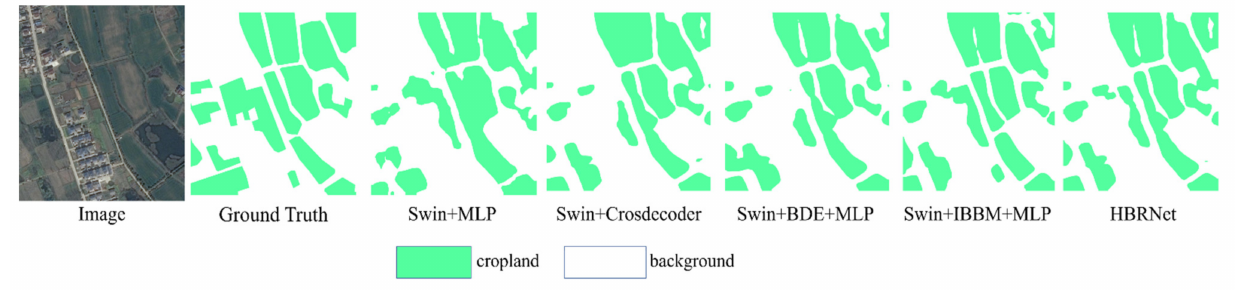
Figure 15. Visualization of the results on the Agriculture dataset after adding different modules on Swin-T.